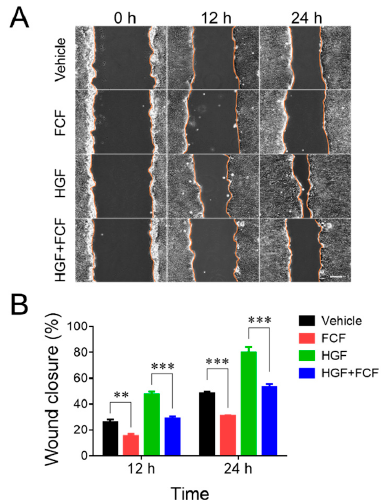
Figure 1. Forchlorfenuron attenuates the spontaneous and hepatocyte growth factor-induced migration of colonic epithelial cells. Confluent HT-29 cell monolayers were pretreated for 2 h with either forchlorfenuron (FCF, 50 µ M), or vehicle (DMSO), and wounded. Spontaneous and hepatocyte growth factor (HGF, 25 ng/mL)-induced wound closure with, or without, FCF was examined at the indicated time points. ( A ) Representative images of wounded HT-29 cell monolayers. ( B ) Quantitation of wound closure during 12 and 24 h of cell migration. Data are presented as a mean ± SE ( n = 5); ** p < 0.01, *** p < 0.001. Scale bar, 100 µm.